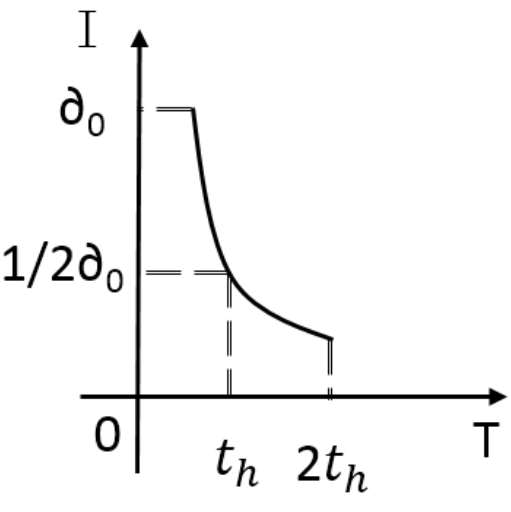
Figure 6. Attenuation